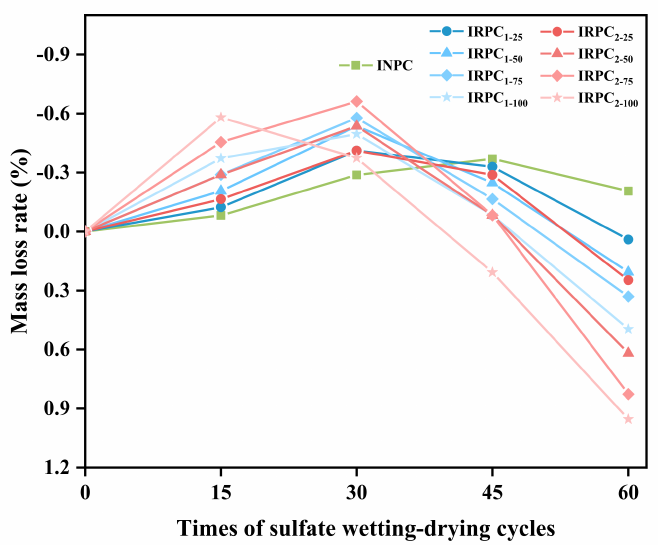
Figure 6. Mass-loss rate of IRPC with variable replacement rates after different sulfate wetting- drying